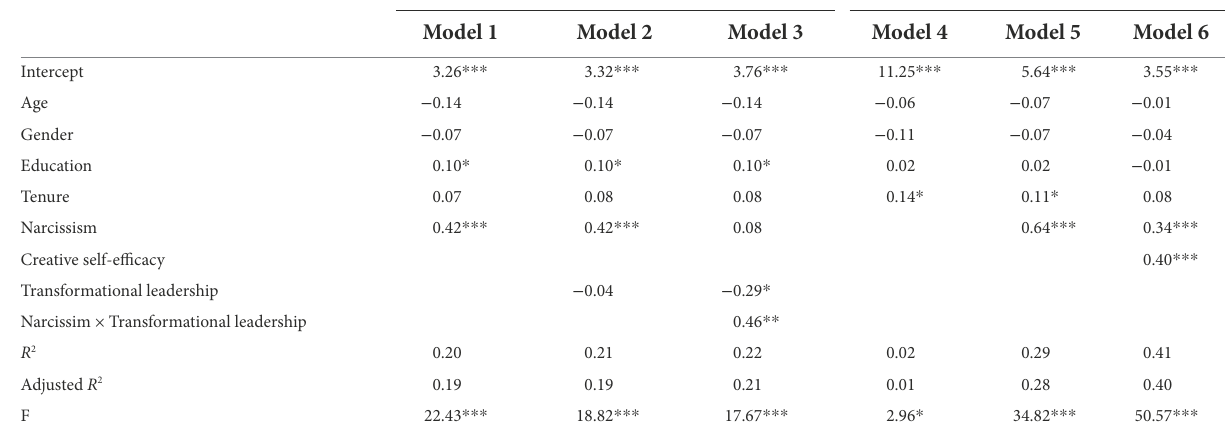
and plotted the interactive effects in Figure 2. Simple slopes analysis indicates that the effect of narcissism was stronger when transformational leadership was high ( β = 0.07, SE = 0.08,